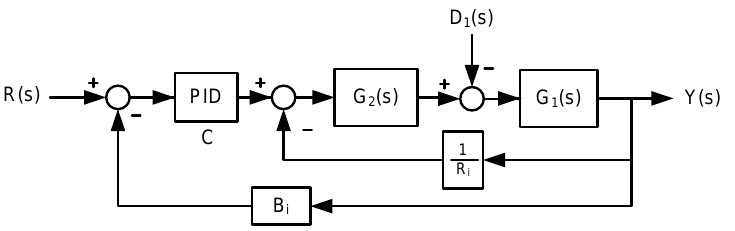
Figure 19. The simplified closed loop control system for stability analysis.